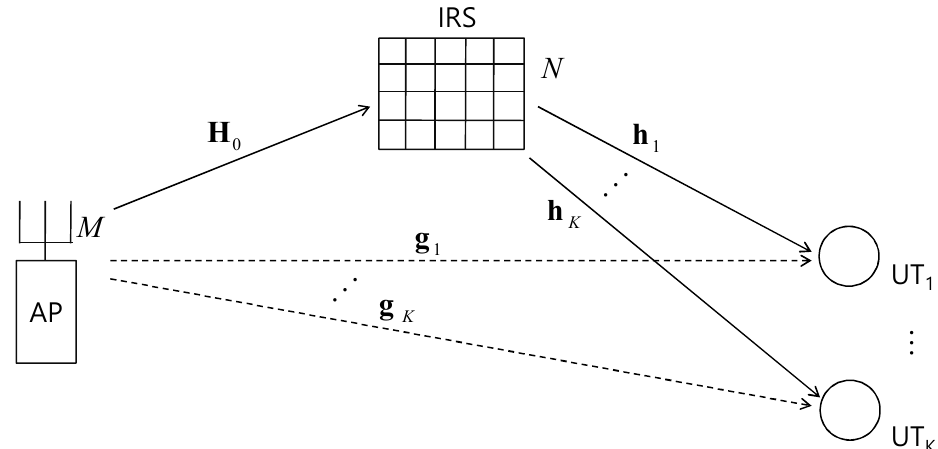
Figure 1. Multicast channel with an AP, an intelligent reflecting surface (IRS) and K user termi- nals